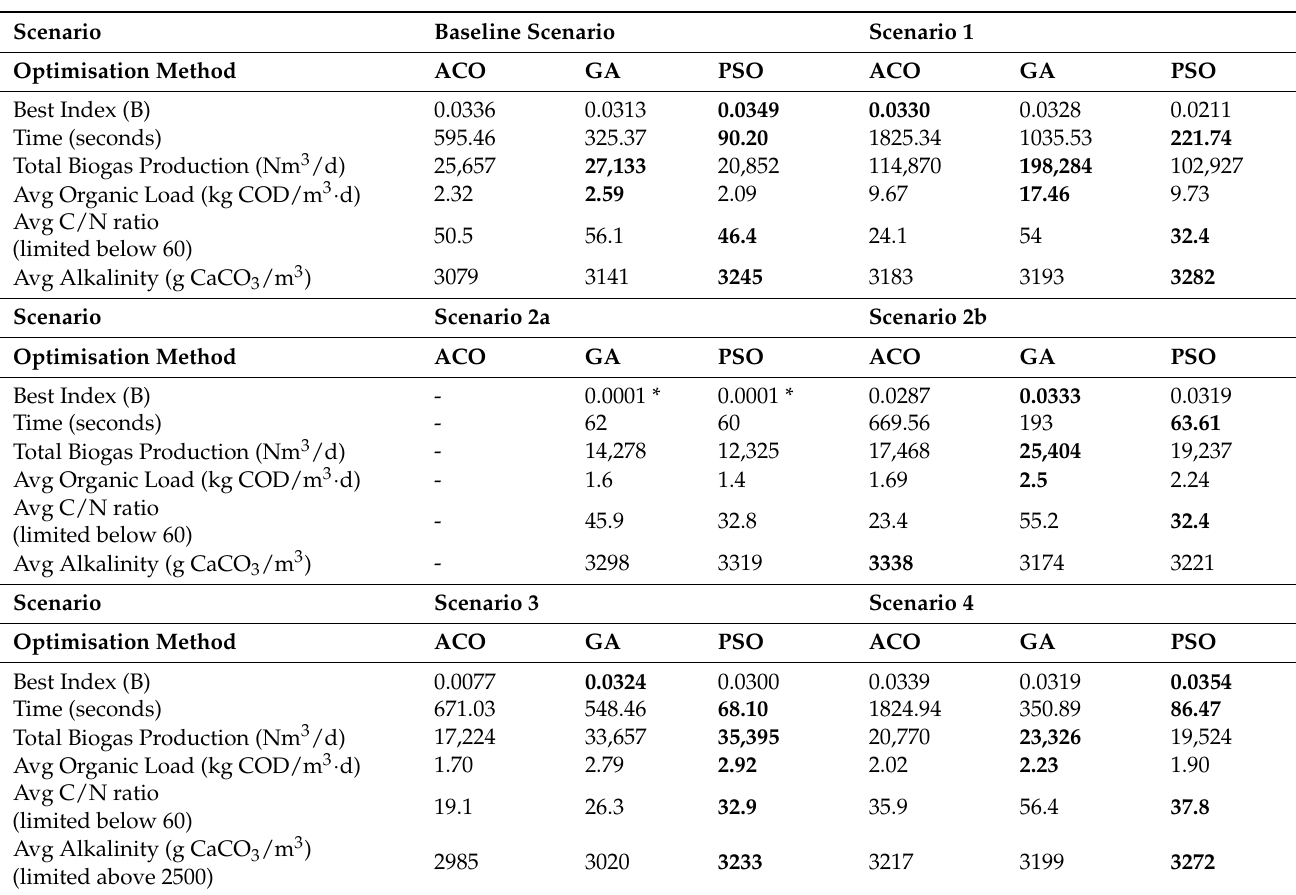
Table 5. Summary of algorithm performance. The best value B is highlighted. Scenario 2a feasible results (*) are associated with a poor solution, so no direct comparison is